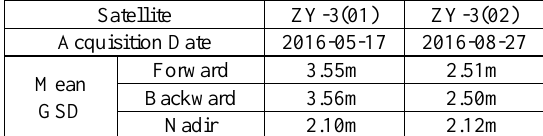
Table 1. Analyzed ZY-3 Image GSD in the experiment